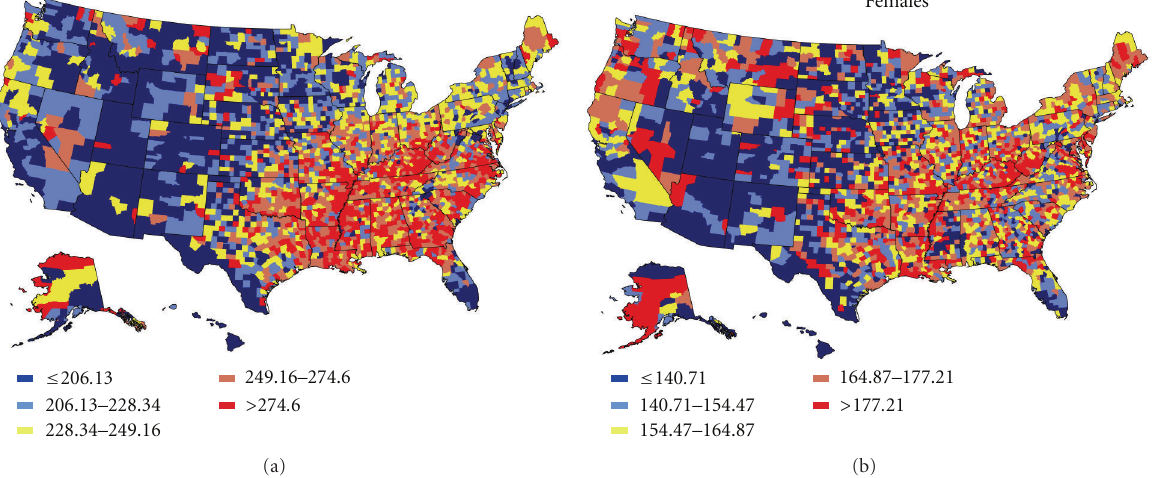
Figure 2: All-cancer mortality rates per 100,000 population (age adjusted to the 2000 population), US males and females, 2003–2007 (3,141 counties).